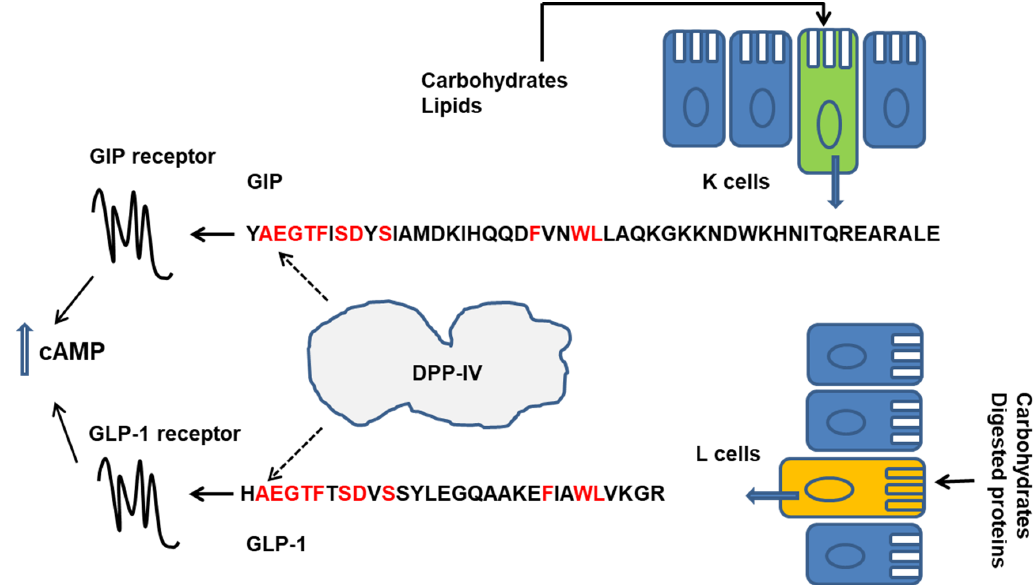
Figure 2. Glucagon-like peptide-1 (GLP-1) and glucose-dependent insulinotropic peptide (GIP), so